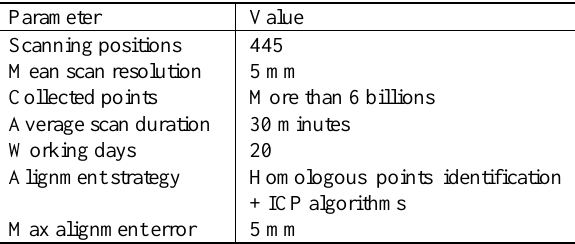
Figure 6. Image-based 3D point cloud model as obtained by means of the UAV flights: top of the tower, the highest portion of roof of St. Stefano Basilica.